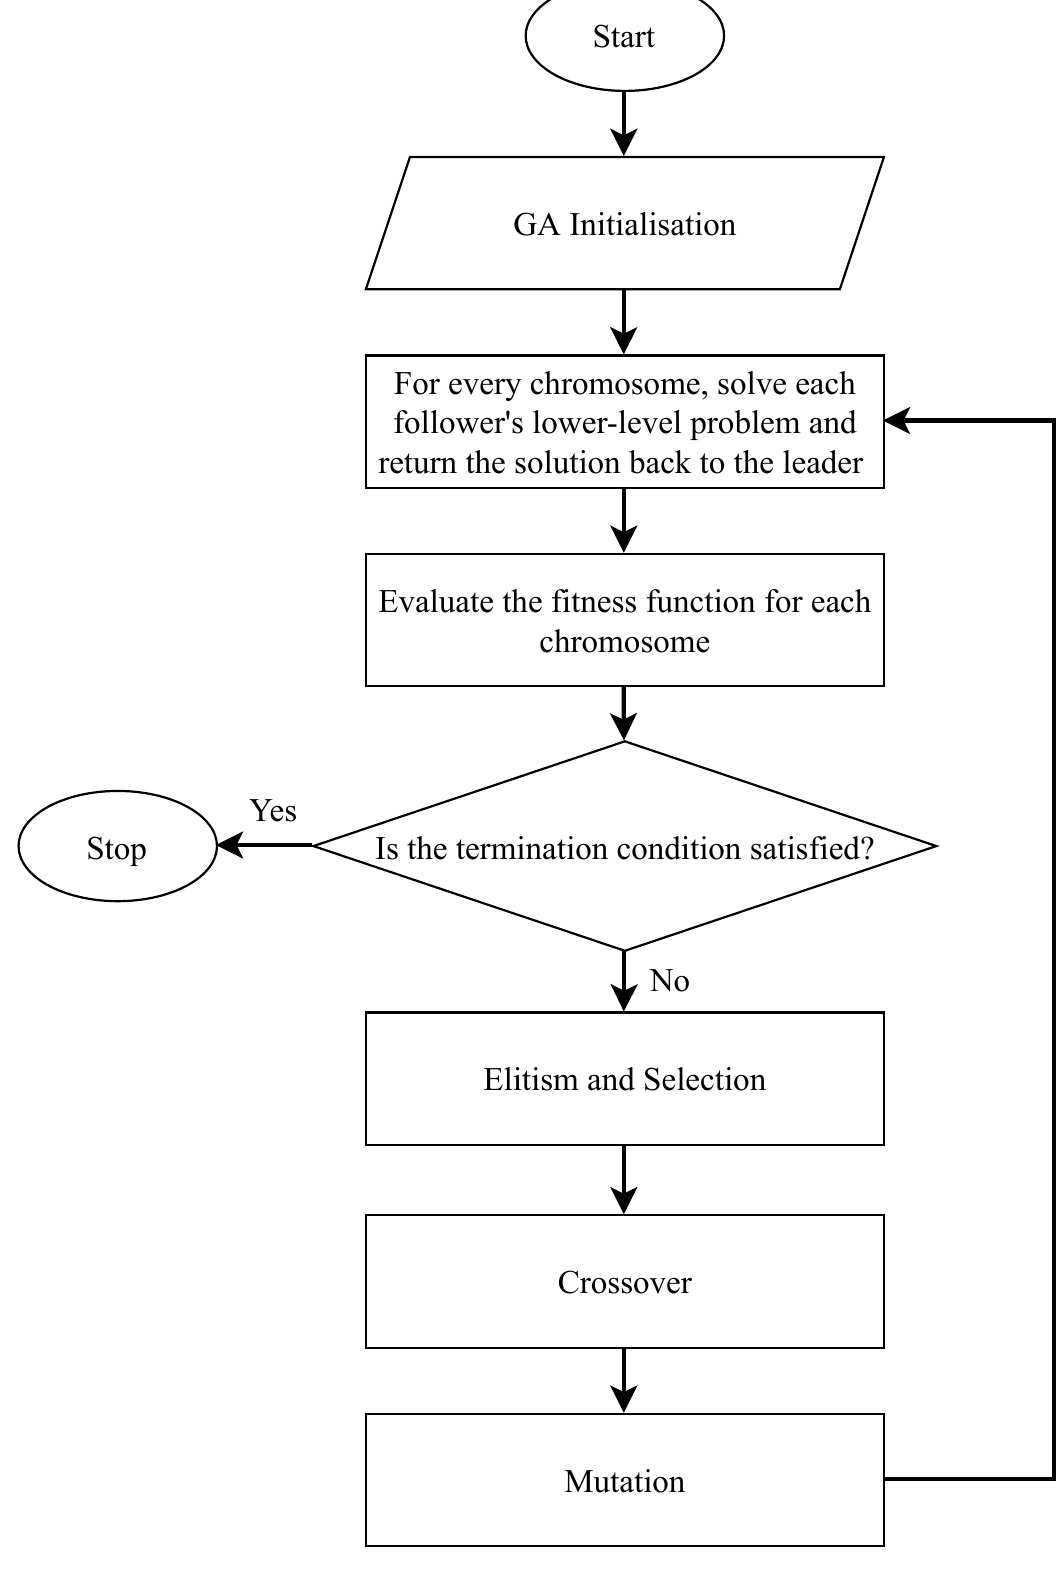
Figure 4. Flowchart of the GA-based